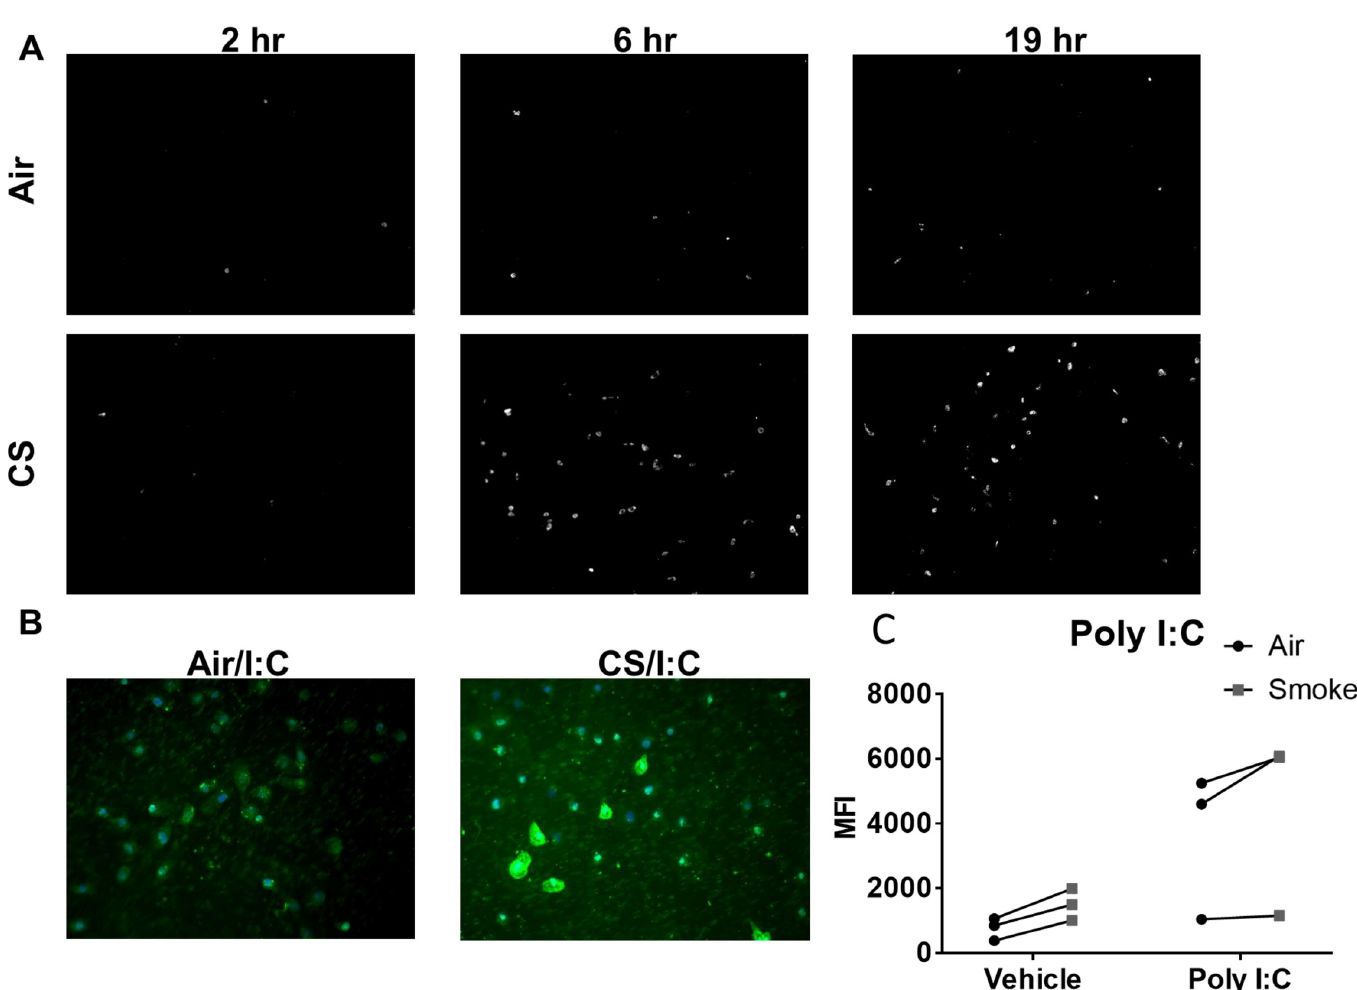
Fig 2. Cigarette smoke increases uptake of poly I:C. Primary human SAEC were exposed to either air or cigarette smoke for 60 minutes at the air-liquid interface. Following exposure cells were treated with 2.5 μ g/mL of fluorescent poly I:C for the indicated times. (A) Time course analysis of fluorescence at 2, 6, and 19 hours post poly I:C treatment. (B) Representative fluorescent images of poly I:C positive cells taken 6 hours post poly I:C treatment. (C) Analysis of cell fluorescence by flow cytometry 6 hours post treatment with poly I:C. The experiment was repeated using SAEC derived from 3 separate donors and each pair of points represents an SAEC strain from a different